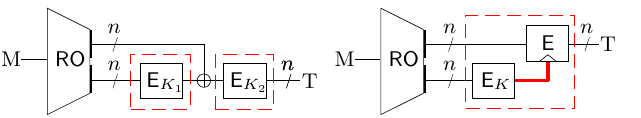
Figure 1: Our new MA modes. The hash H is modeled as a random oracle RO . Components in the red dashed squares are protected to be side-channel secure (modeled as “leak free”): these include all the 4 blockcipher calls and the red bold wire in the right part. (left) LRW1-based hash-then-MAC LRWHM ; (right) rekeying hash-then-MAC RHM